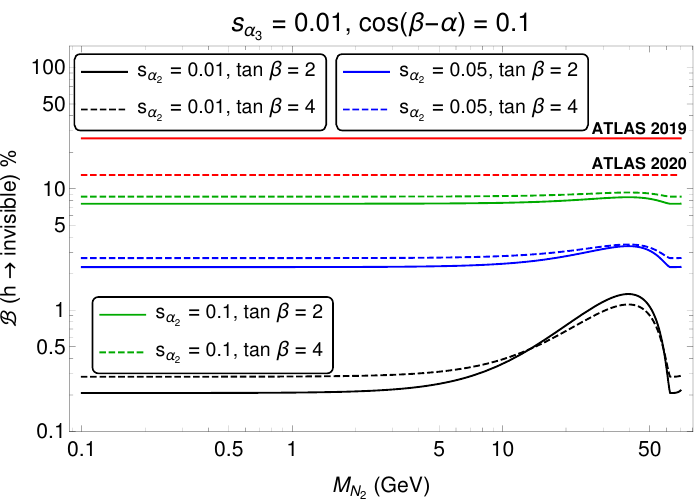
Figure 30 . Higgs invisible branching fraction as a function of M N and s α each is shown. The red solid line is the upper bound from ATLAS 2019 [118] while the red 2 dashed line is the upper bound from their recent announcement in April 2020 [119].